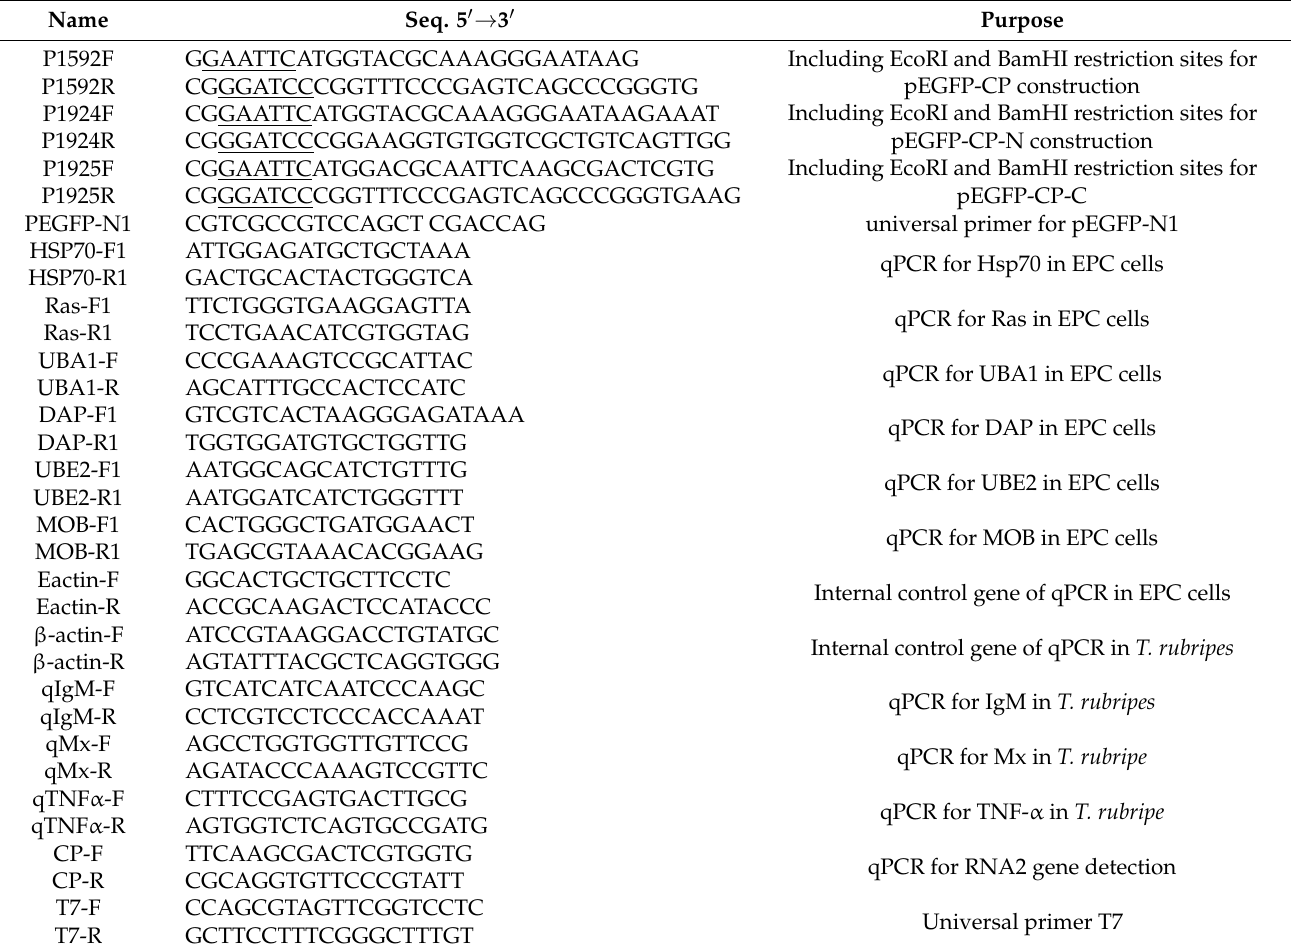
Table 1. Primers used in the